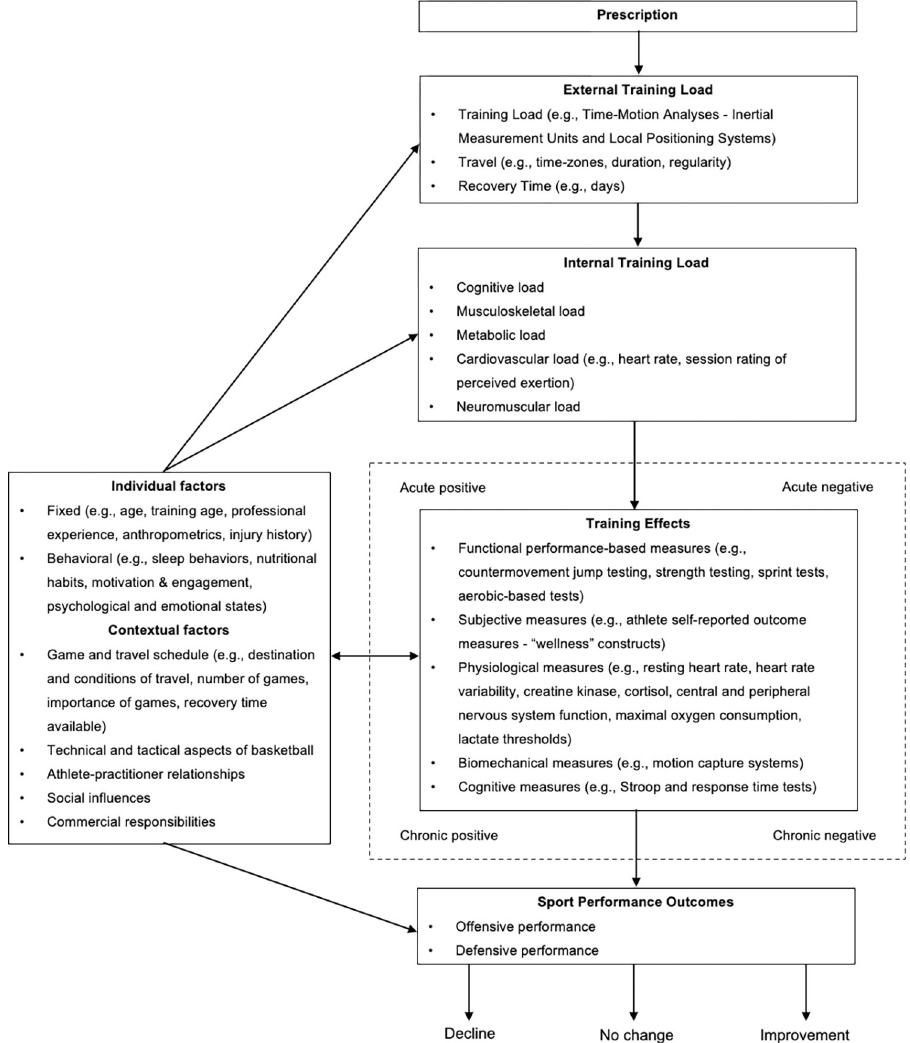
Fig 1. Conceptual framework for physical training in professional basketball, adapted from the work by Jeffries et al. [12] Prescription represents the short and long-term planning and execution of training, competition and travel over the course of the season (i.e., nature and organization of training sessions and travel). External load represents the physical demands associated with training, competition, and travel during the season, and training load is the specific stimulus induced by both training sessions and competition. Internal load represents the psychophysiological responses occurring during the execution of training. Contextual factors are defined as factors that are not part of the main training process, such as environmental, social, and cultural factors, but can influence the training process or outcome. Individual factors are characteristics of the individual athlete, such as genetics, psychological traits and states, and training background, which can influence the training process or outcome. Training effects can be acute or chronic, and positive or negative, effects caused and occurring after the training session, and can be assessed using functional, subjective, physiological, biomechanical and cognitive measures. The bidirectional arrow represents a reciprocal nature of interactions between training effects and individual/contextual factors. For example, a negative training effect (e.g., increased fatigue or poor sleep) can act as an individual factor influencing the internal training load in the subsequent session. Sports performance outcomes are defined as the result of the balance between positive and negative training